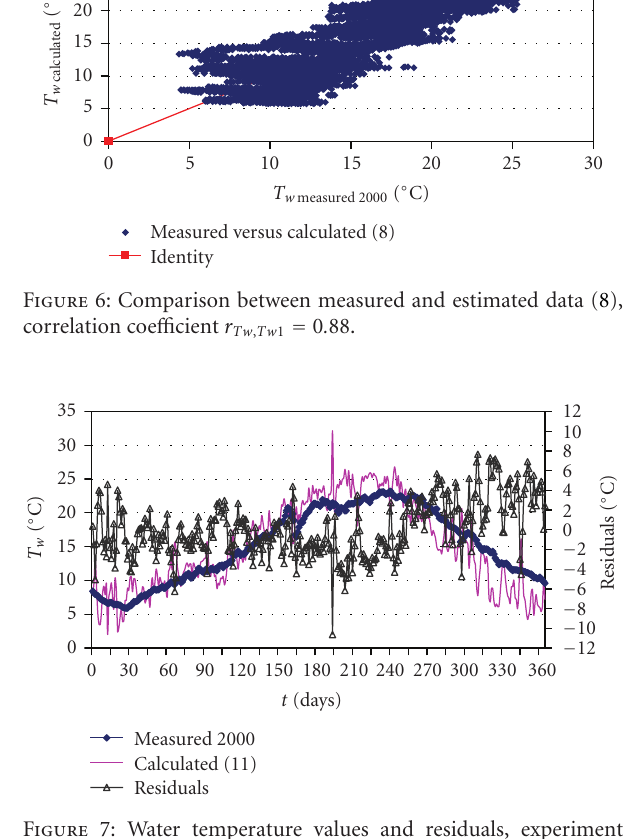
Figure 7: Water temperature values and residuals, experiment without standardization (daily average values).